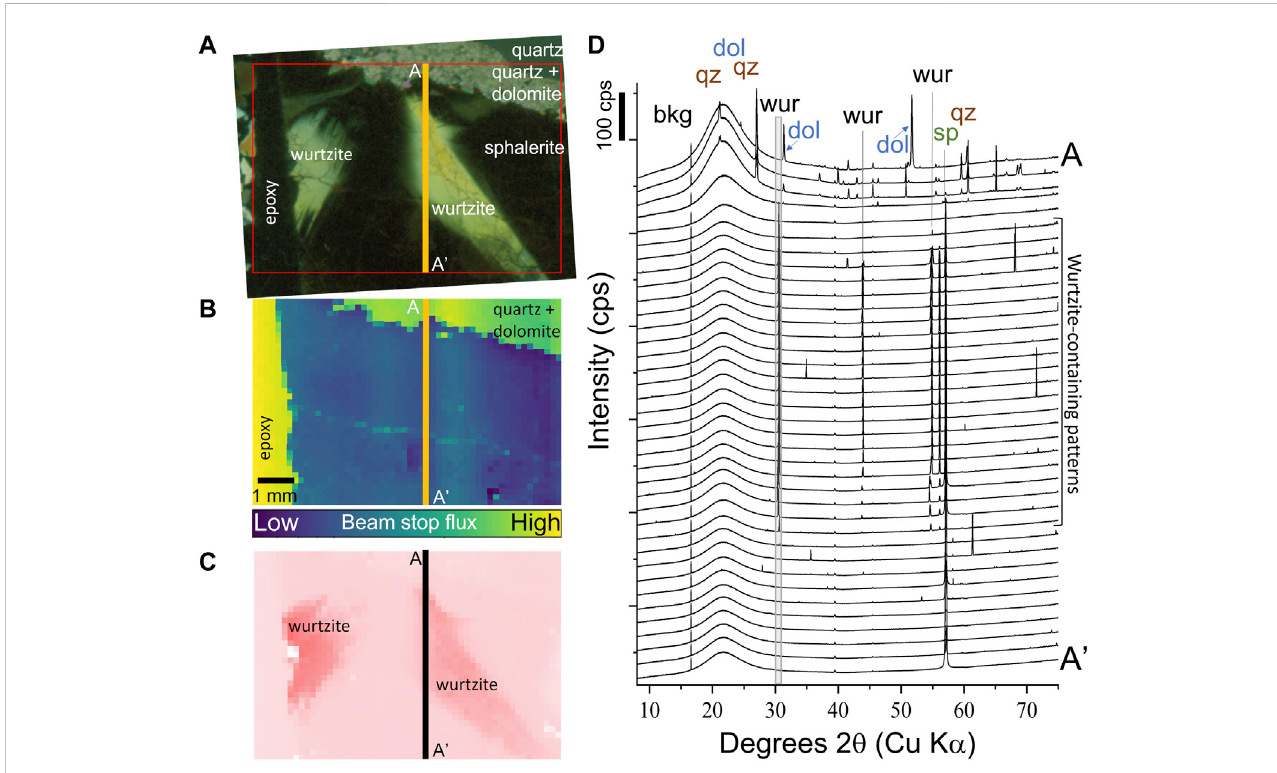
FIGURE 7 Synchrotron-basedXRD investigation ofanisotropic regionsinCentralTennesseeZnS. (A) Cross polarized transmitted light(redbox istheregion shown in Figures 7B,C). (B) Total absorption map (scale bar same for Figures 7A,C) showing more X-rays transmitted through epoxy, quartz, and dolomite than ZnS. (C) ZnS polymorph distribution (sum of wurtzite peak intensity at 30 ° 2 θ peak). Wurtzite appears dark pink, while all other phases appear light pink (meaning there is no peak at 30 ° 2 θ ). (D) Diffraction patterns for transect A to A ′ , demonstrating the presence of wurtzite peaks at 30 ° 2 θ and ~55 ° 2 θ and sphalerite peak at about 57 ° 2 θ in the middle XRD